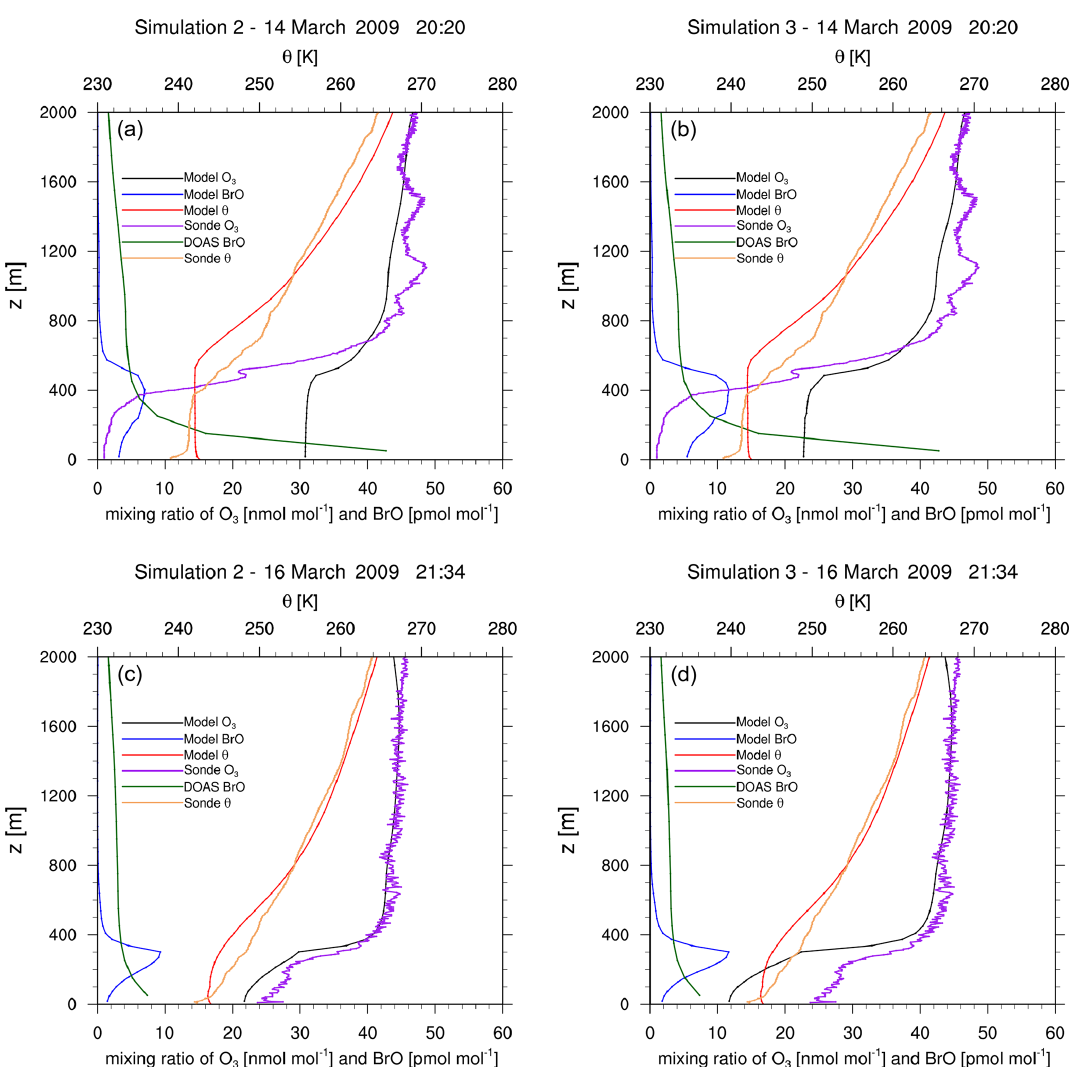
Figure 8. Vertical profiles of measured and modeled ozone, of potential temperature θ , and of BrO at Utqia˙gvik on 14 March (a, b) and on 16 March (c, d) 2009. The time zone is GMT + 0. Measurements are from upward flights using ozone sondes (Oltmans et al., 2012) and DOAS measurements (Frieß et al.,